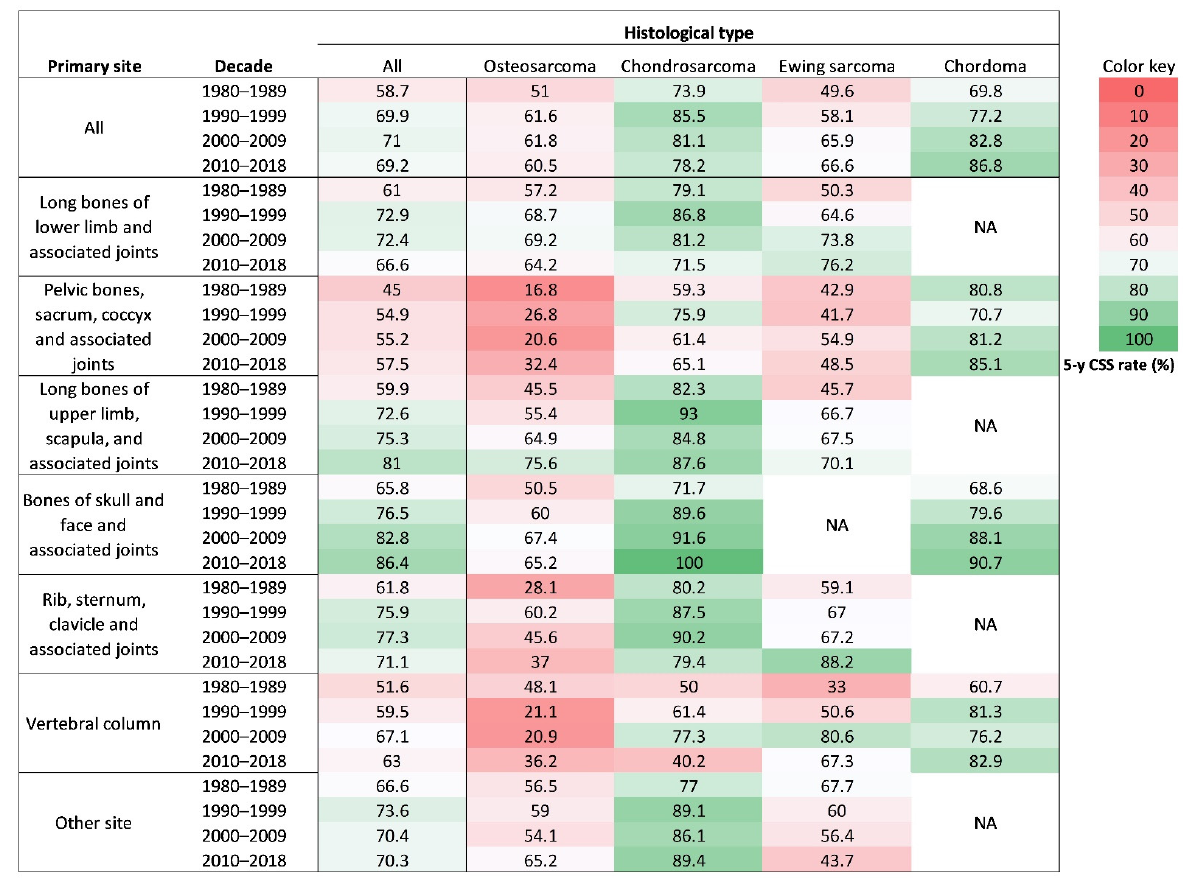
Figure 7. A heat map visually showing 5-year CSS rate changes in histological type and tumor site-combined categories. CSS: bone sarcomas-specific survival. Table 3. Trends in the adjusted HR for CSM in specific histological